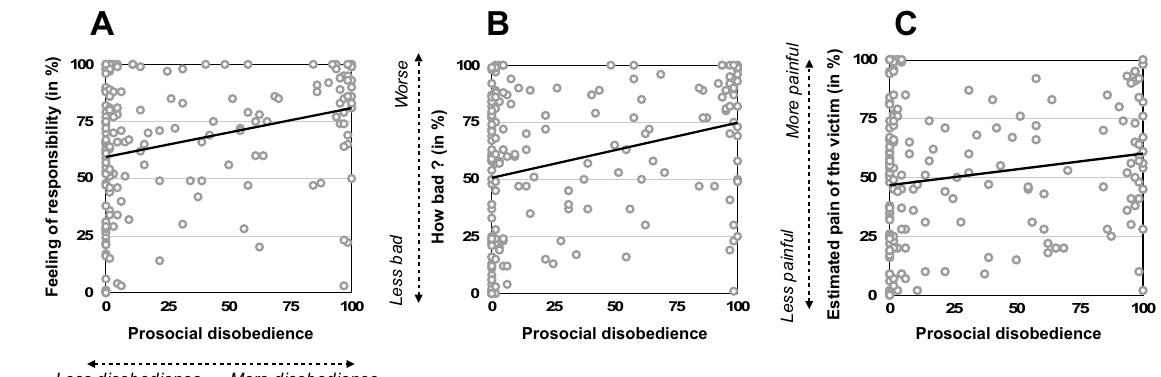
Figure 3. Graphical representation of Pearson correlations between prosocial disobedience and ( A ) feeling of responsibility, ( B ) how bad agents felt during the task when they administered shocks to the ‘victim’, and ( C ) how painful they estimated the shock delivered to the ‘victim’ was. All tests were